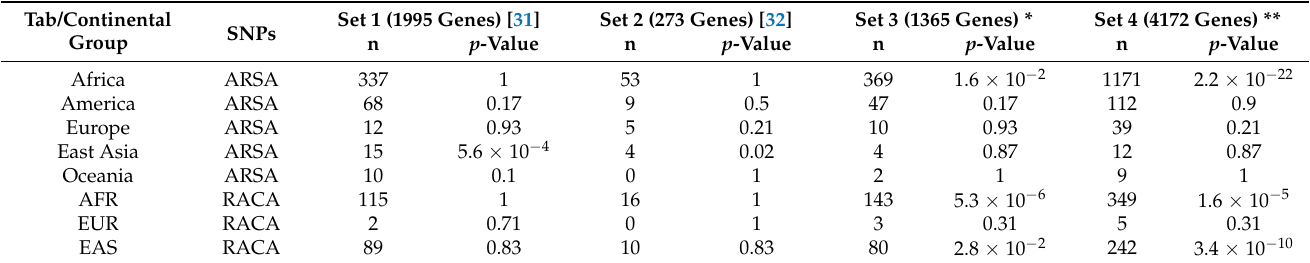
Table 5. The number of ARSA- and RACA-associated genes shared with the published core sets of gens under natural